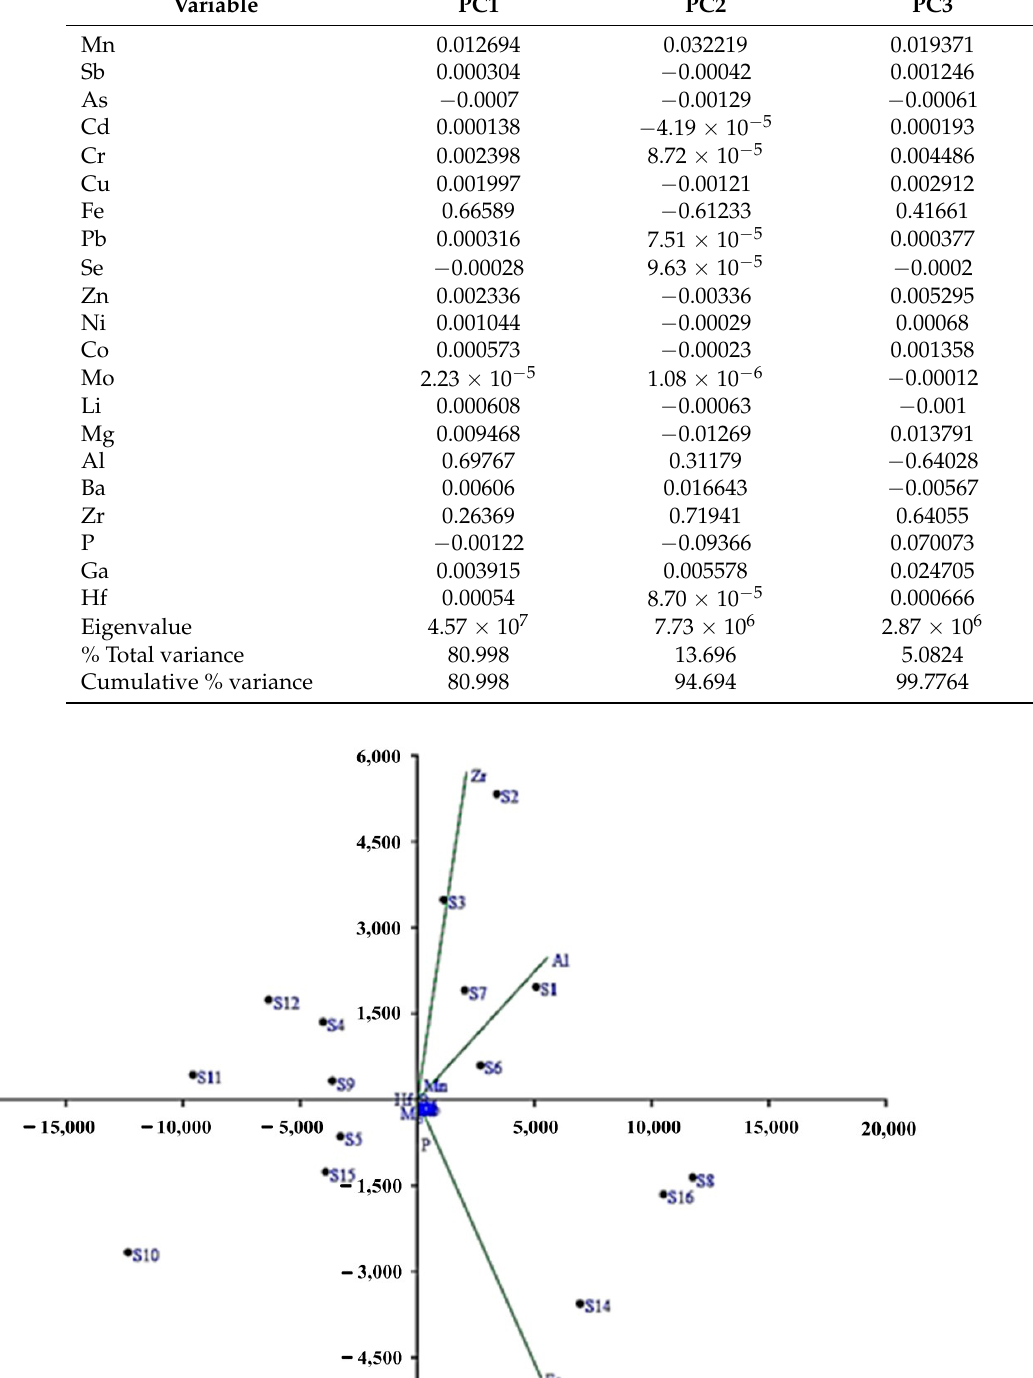
Table 8. Principal component analysis results.